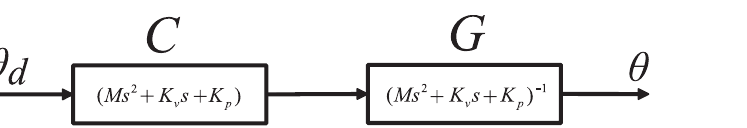
Fig 1. Simplified block diagram of the arm system linearized by the CTC. The closed-loop dynamics of the arm can be expressed as a cascade combination of a controller C and a plant G . θ angle, respectively.